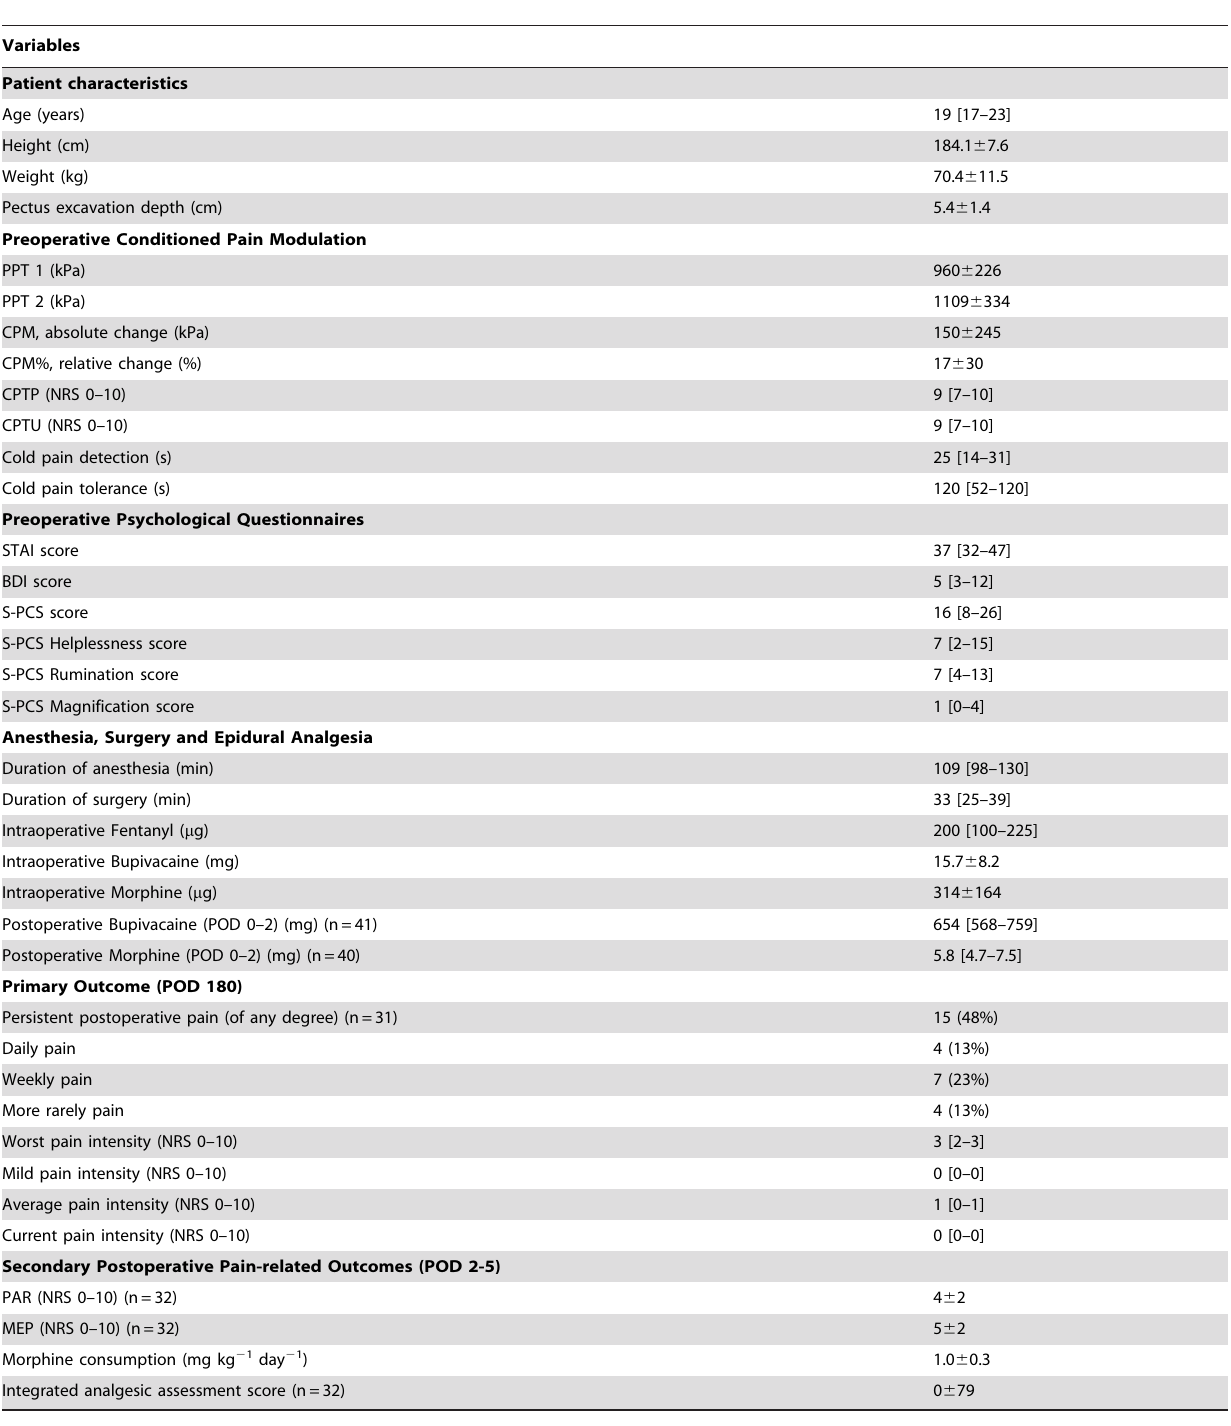
Table 1. Patient Characteristics, Preoperative Predictors and Postoperative Pain-related Outcomes (N= 42).